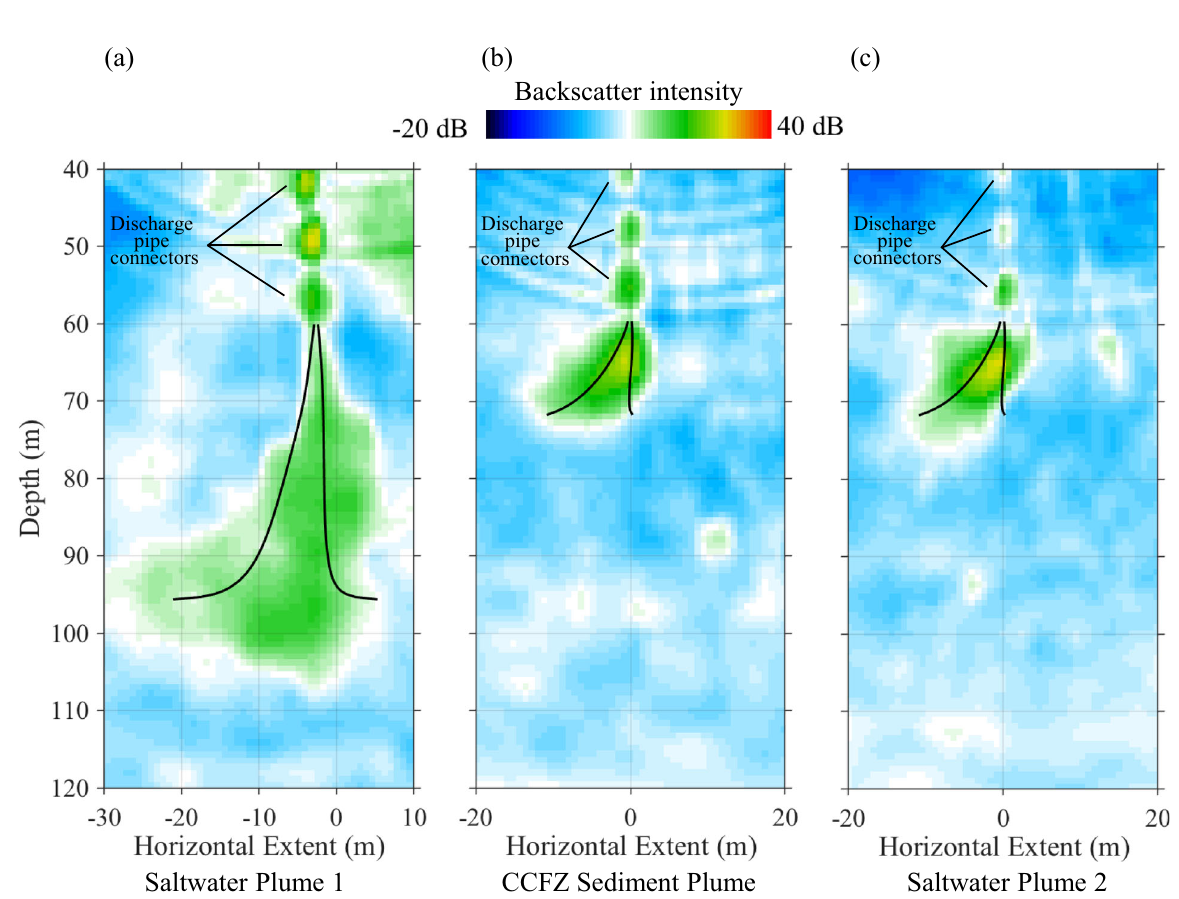
Fig. 2 PADS backscatter intensity images. a Saltwater plume 1, 30 min after the start of a 45-min release, b CCFZ sediment plume, 22 min after the start of the release, and c saltwater plume 2, 19 min after the start of the release. The superimposed black lines are the predictions from the DP1 model (see “ Dynamic plume models ” section). The three intensity patches at the top of each image are acoustic re fl ections from the connectors of the discharge pipe, which vary in intensity because of slight changes of PADS alignment during the discharge. It took about 1 – 3 min for water exiting the discharge nozzle at 60 m depth to descend to the base of the dynamic plume. The DP1 model density, vertical velocity, and width results are in Supplementary Fig. 4. The ocean background backscatter intensity observed by the PADS is in Supplementary Fig.